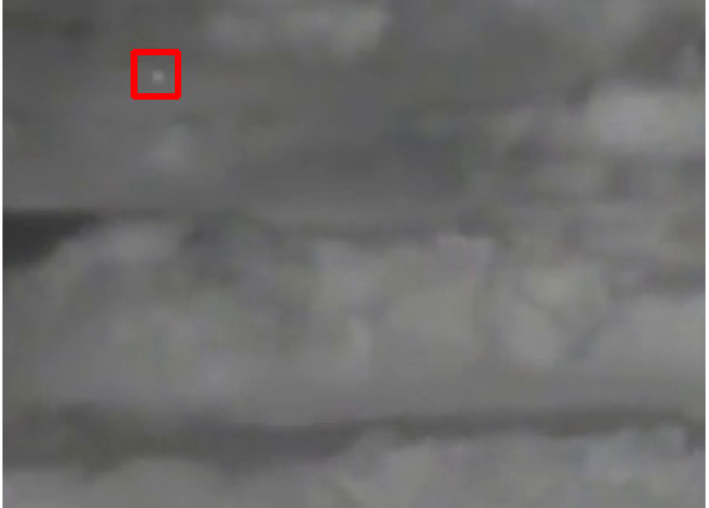
Figure 7. A real, clean infrared small target